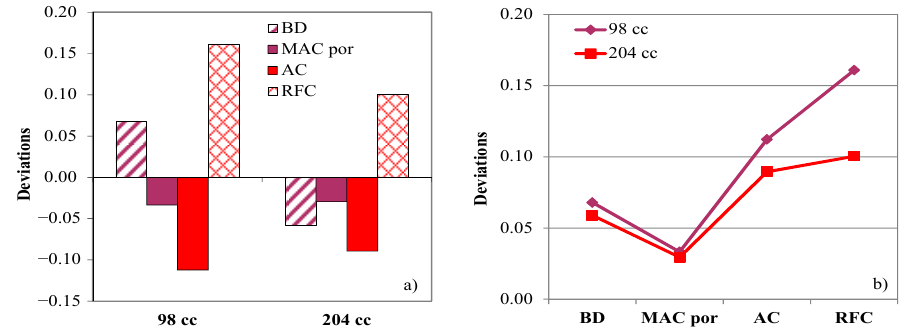
Figure 5. Deviations (with sign and in absolute value, a and b panel, respectively) of bulk density (BD; g · cm − 3 ), macroporosity (MAC por ; cm 3 · cm − 3 ), air capacity (AC; cm 3 · cm − 3 ) and relative field capacity (RFC; dimensionless) between measured and reference mean values, obtained using soil sampler of 98 and 204 cm 3 .